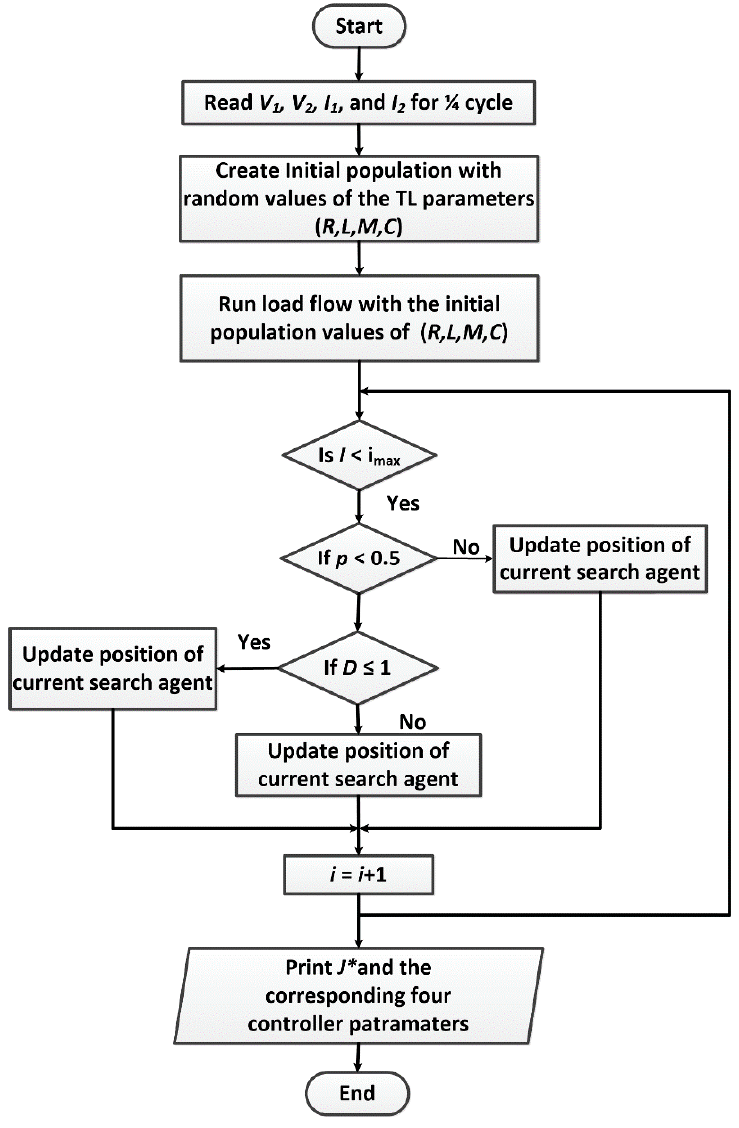
Figure 2. The proposed WOA flowchart for TL parameters estimation.